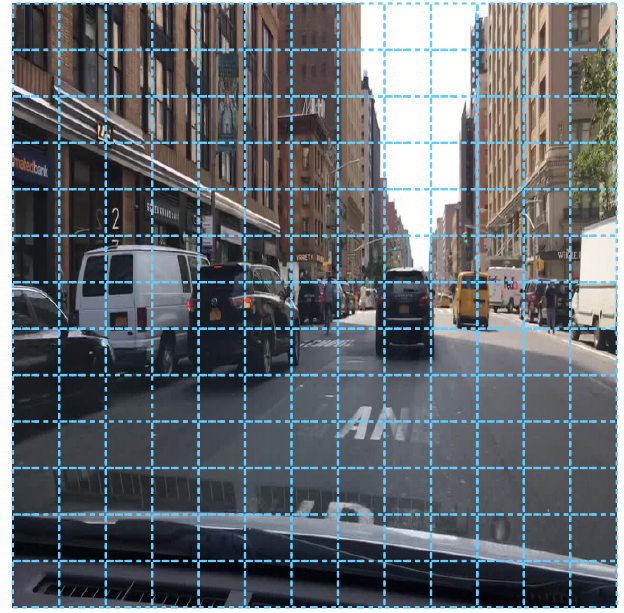
Figure 7. YOLOv4: default 13 × 13